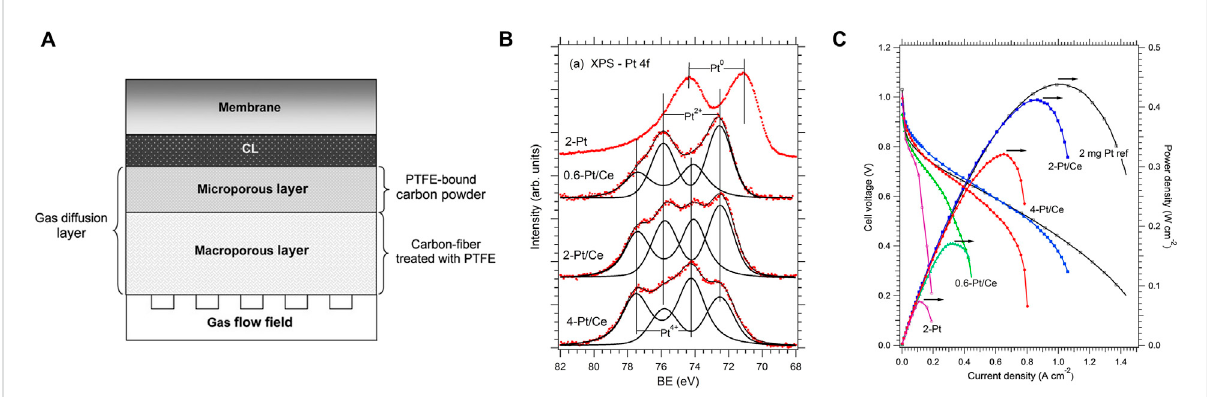
FIGURE 10 ApplicationsofCeO 2 inPEMFC: (A) BasicstructureofaPEMFC.Reproducedwithpermission(Majlanetal.,2018).Copyright2018,Elsevier.